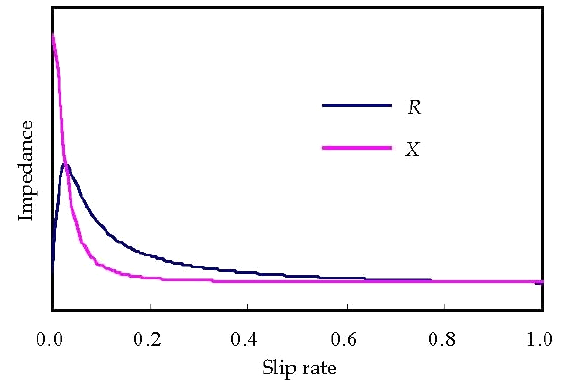
Figure 2. Input impedance at different slip rates.